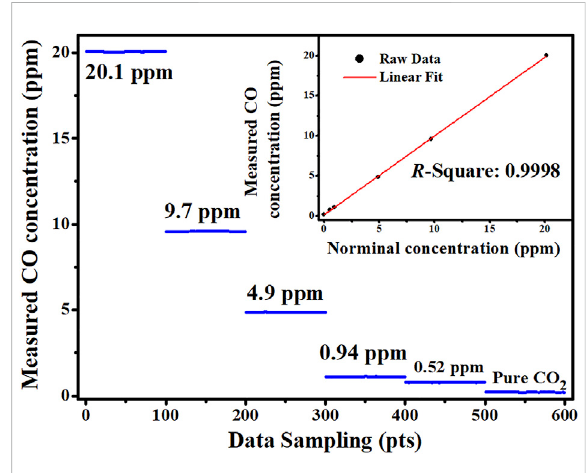
FIGURE 4 Absorption lines of CO from 1.5 μ m to 5 μ m.